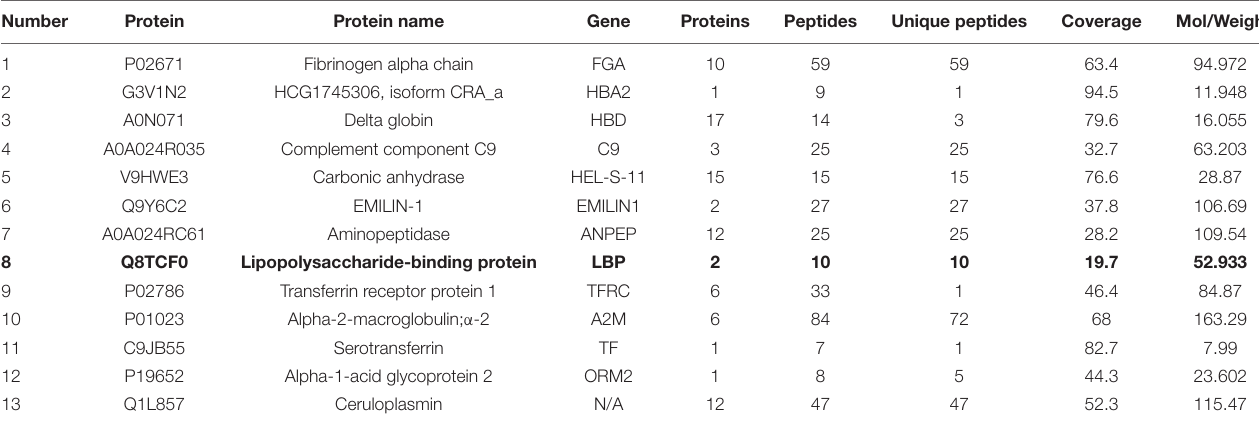
Bold values are proteins that were analyzed in this